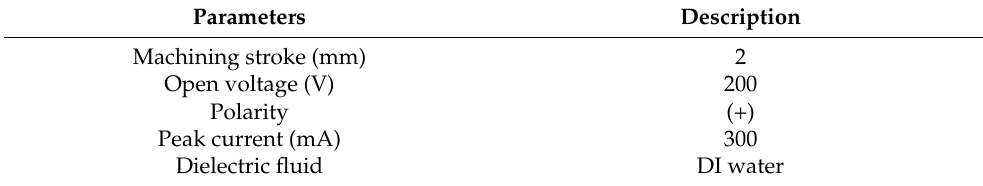
Table 2. Constant parameters and setting values of the µ -EDD experiments.